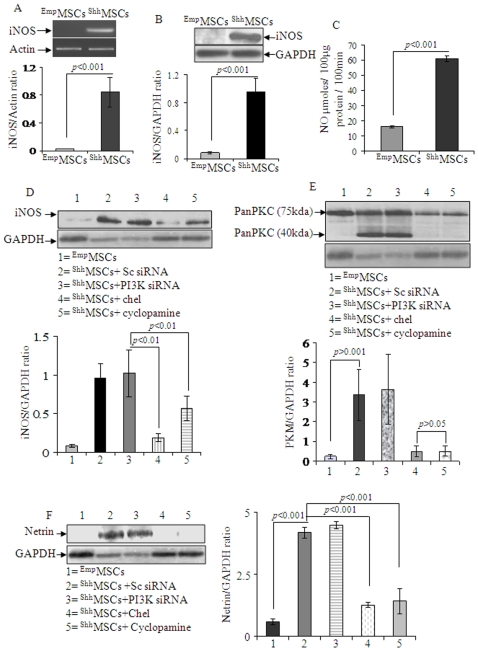

ShhMSCs upregulated iNOS and netrin-1 expression.(A) RT-PCR and (B) Western blot showing significantly higher level iNOS gene and protein expression respectively in ShhMSCs as compared with EmpMSCs. (C) iNOS activity assay showed increased NO production (in 100-min/100 µg protein) in ShhMSCs as compared with EmpMSCs. This result was in accordance with higher level expression of iNOS in ShhMSCs thus indicating its functionally active status. (D) Transfection of ShhMSCs with Sc siRNA and PI3K specific siRNA failed to abrogate iNOS expression. On the other hand, pretreatment of ShhMSCs with 2.5 µM chel or 1 µM cyclopamine significantly blocked iNOS expression in ShhMSCs. (E) Western blot and densitometry of changes in PKM expression in ShhMSCs showed significantly higher level expression of 45 kDa fragment of PKC (PKM) in ShhMSCs as compared to EmpMSCs which was not blocked by PI3K specific RNA interference using Sc siRNA as a control. However, PKM fraction was sensitive to 2.5 µM chel or 1 µM cyclopamine. (F) Western blot showing significantly higher level protein expression of netrin-1 in ShhMSCs (Lanes-2 & 3) as compared with EmpMSCs (Lane-1). Netrin-1 expression was not abrogated by transfection of ShhMSCs with PI3K siRNA or Sc siRNA (Lanes-2 & 3). However, netrin-1 expression in ShhMSCs was abrogated by pretreatment of ShhMSCs with 2.5 µM chel (Lane-4) or 1 µM cyclopamine (Lane-5).